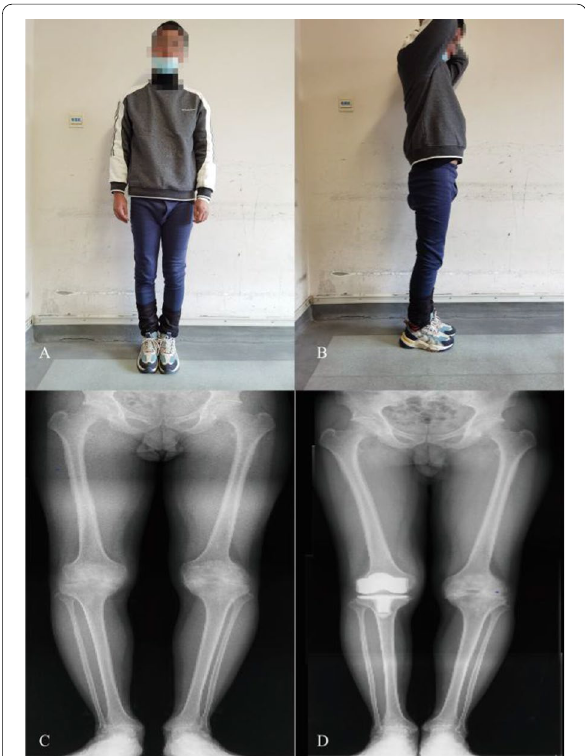
Fig. 6 Clinical and radiographic views of both lower